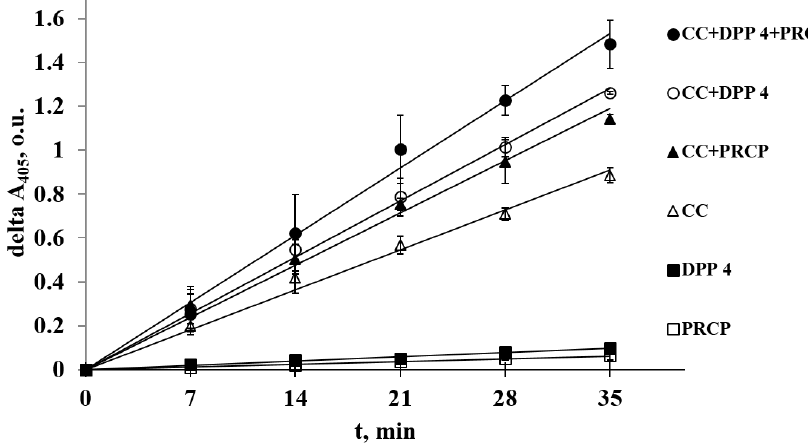
Figure 3. Proteolysis of gliadins by six samples of T. molitor digestive peptidase preparations: 1. PRCP (white squares), 2. DPP 4 (black squares), 3. CC (white triangles), 4. CC + PRCP mixture (black triangles), 5. CC + DPP 4 mixture (white circles), and 6. CC + DPP 4 + PRCP mixture (black circles) (description of the curves from bottom to top). Proteolysis of gliadins was detected by an increase in free amino groups using 2,4,6-trinitrobenzene sulfonic acid (TNBS). The error bars represent standard deviation .